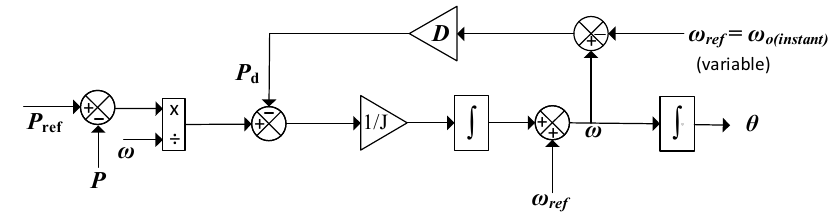
Figure 8. Master-slave configuration of VSG control.